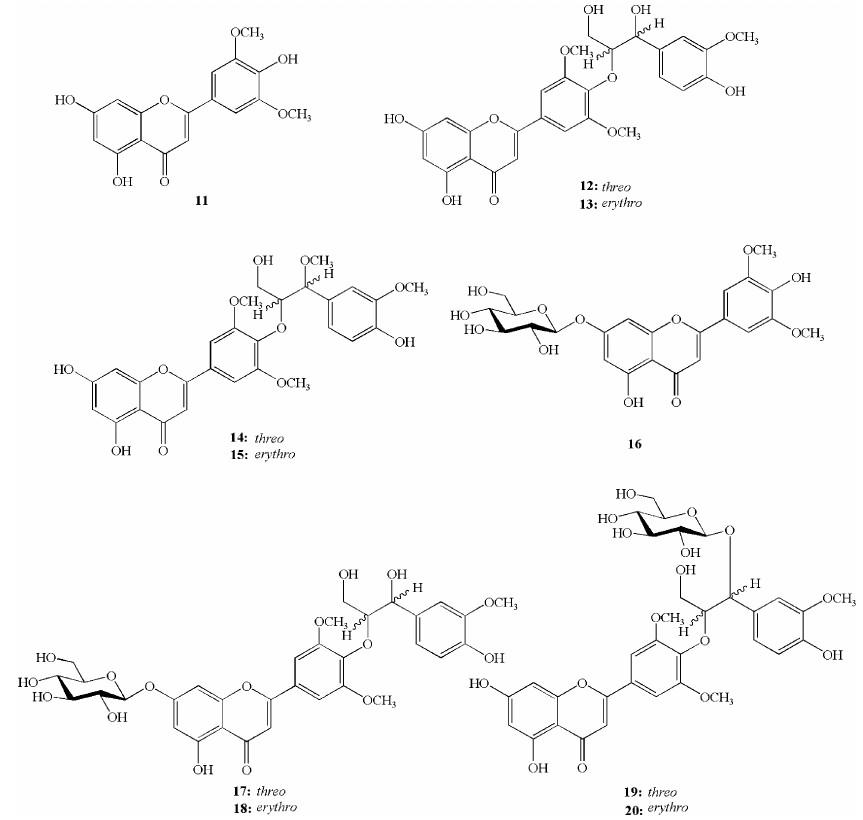
Figure 3. Chemical structures of compounds ( 11 – 20 ) isolated from the aerial parts of Z. latifolia .